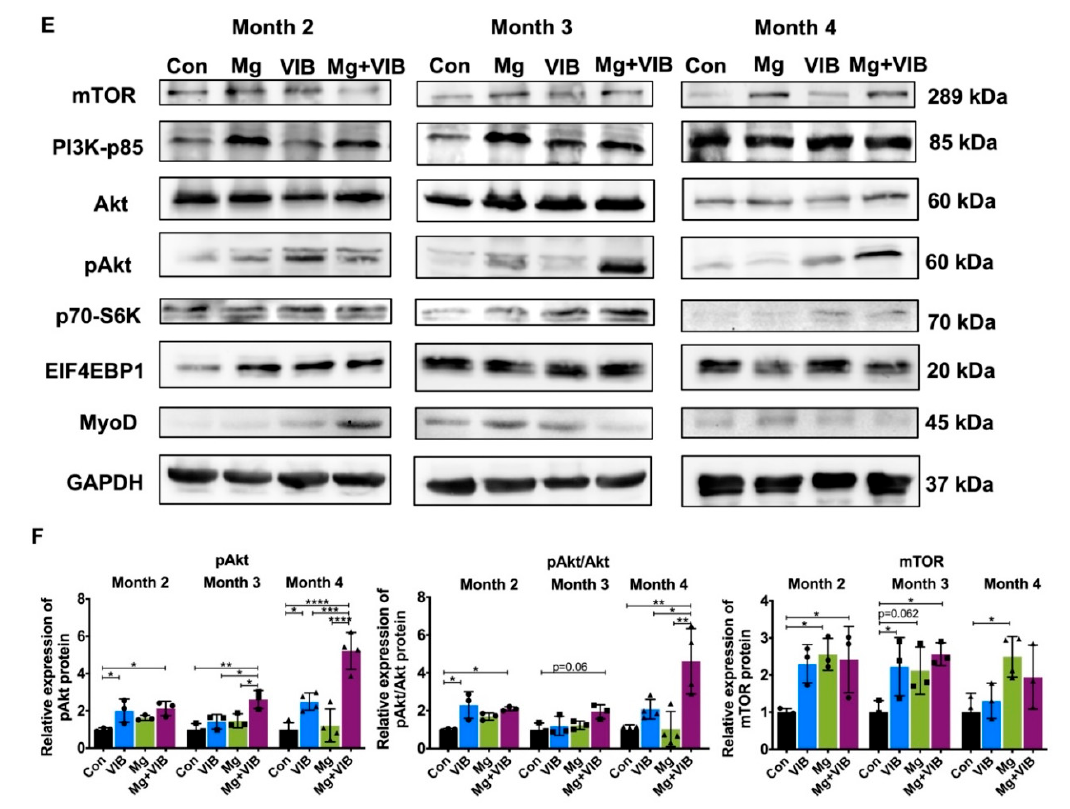
Figure 5. Treatment effects on muscle hypertrophy and atrophy in SAMP8 mice upon different time points. ( A – C ) Expression of IGF-1, MyoD, MyoG, Myf5 and Myf6 mRNA in different treatment groups at month 2, 3 and 4. ( D ) MuRF1 and MAFbx mRNA expression levels in the VIB group were significantly lower than in the Con group at month 4. ( E , F ) Western blots of protein expressions of mTOR, PI3K-p85, Akt, pAkt, p70-S6K, EIF4EBP1, MyoD and GAPDH at month 2, 3 and 4. * p < 0.05, ** p < 0.01, *** p < 0.001 and **** p < 0.0001, n = 3.